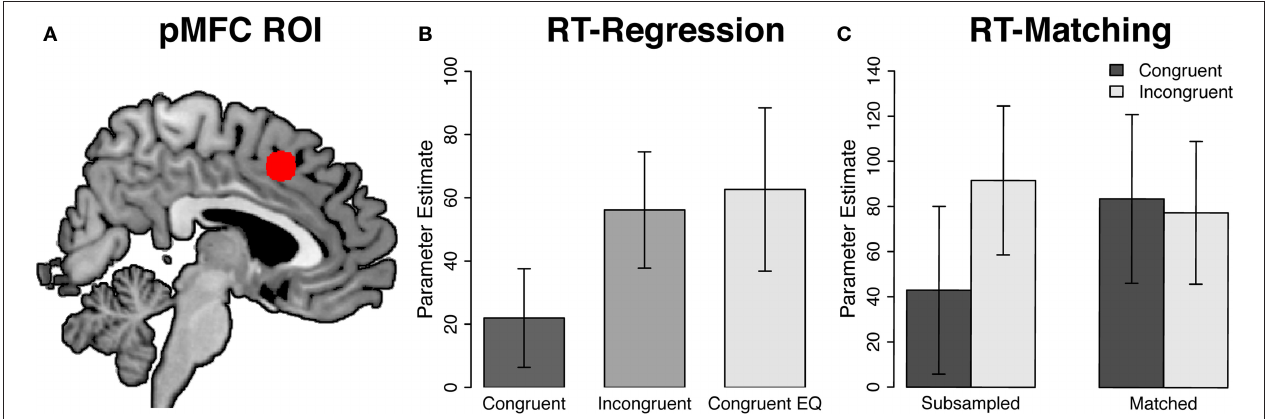
matching analysis. Activity in the pMFC ROI was significantly greater in incongruent than in congruent trials in the RT-subsampled data [ t (20) = 3.17, p = 0.005] but not in the RT-matched data [ t (20) = − 0.44, p = 0.67]. Furthermore, the congruency effect in the pMFC ROI was significantly greater in the RT-subsampled data than in the RT-matched data [ F (1, 20) = 9.33, p = 0.006]. Error bars denote ± 1 SE of the